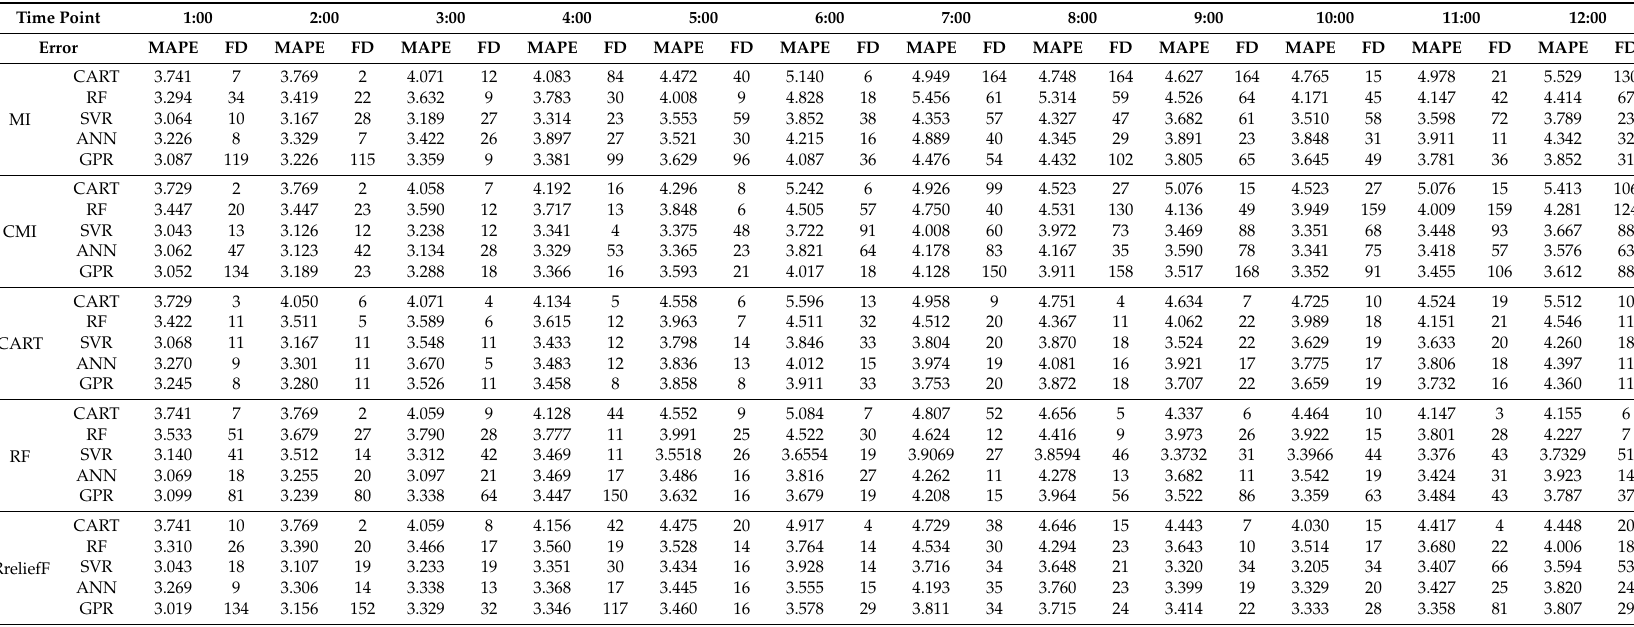
Table A1. Optimal feature subset construction of different hours from 1:00 to 12:00 with different methods for New